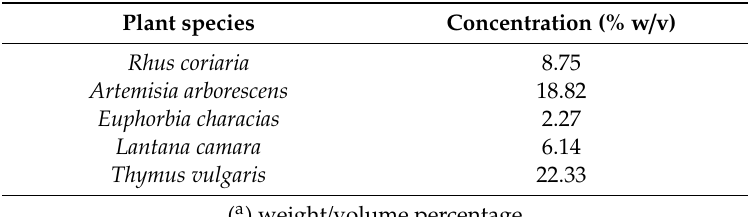
Table 1. Concentration of the used extracts (% w / v) ( a